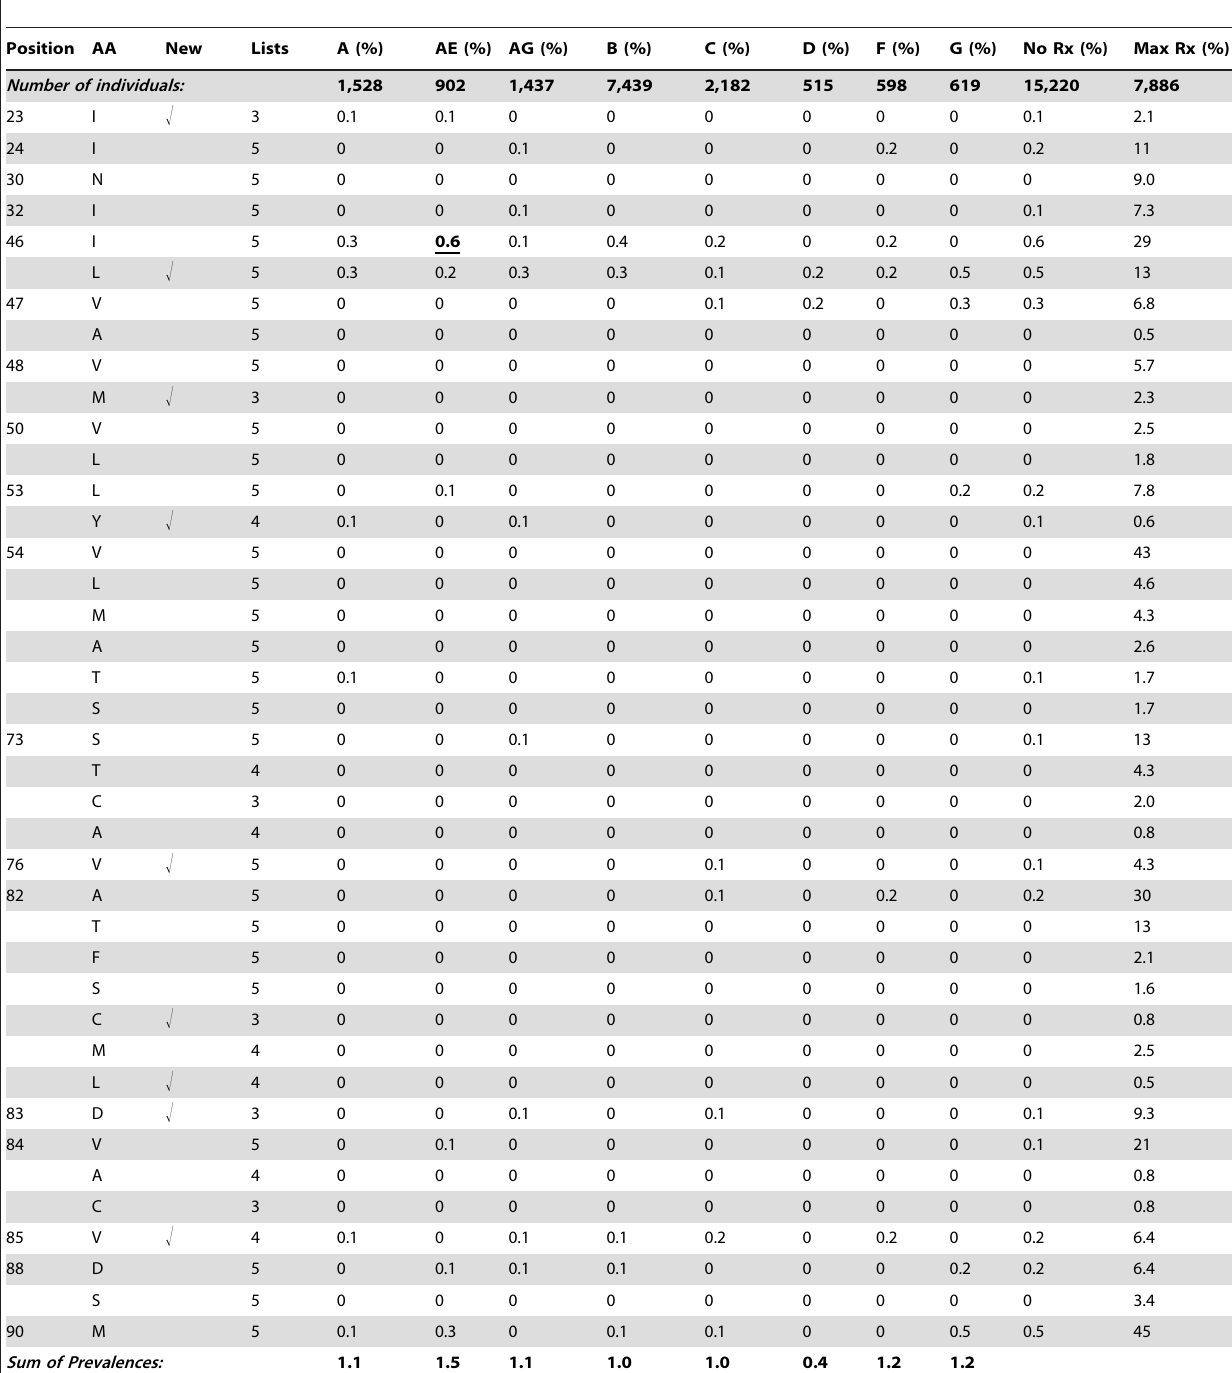
Table 4. Protease Inhibitor (PI) Surveillance Drug Resistance Mutation (SDRM) List: 40 Mutations at 18 Positions *